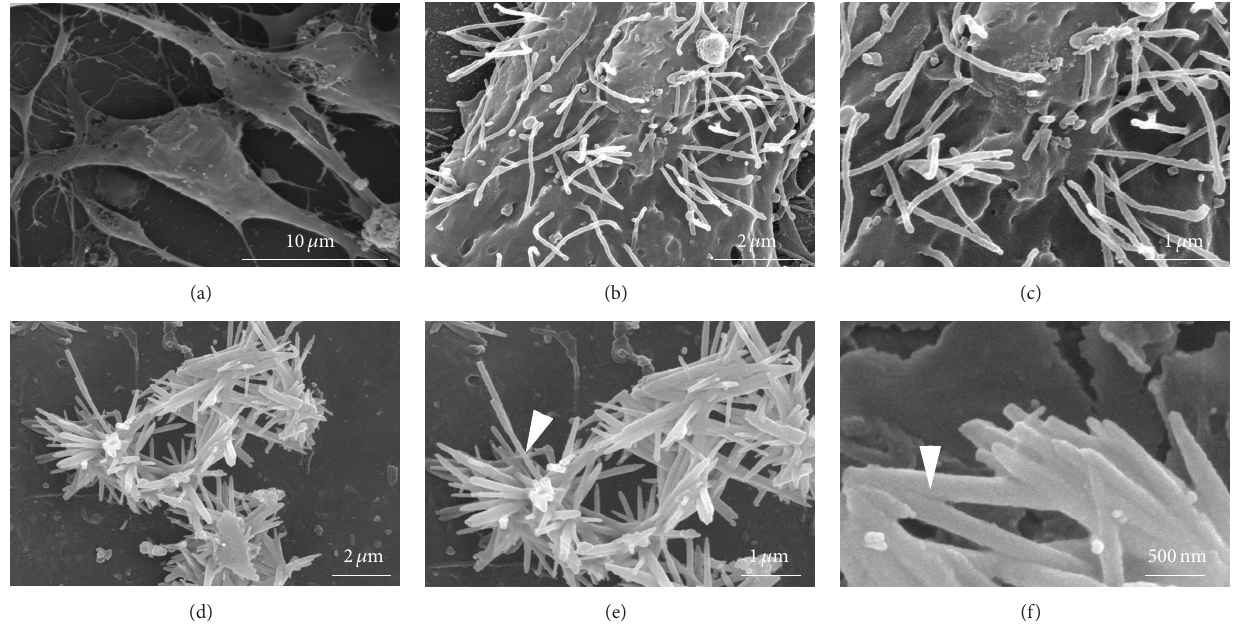
Figure 5: The surface of differentiated cells observed by scanning electron microscopy. (a) The surface of the cochlear multipotent cells had no stereocilia. ((b) and (c)) Cells differentiated on poly-L-lysine (as shown in Figure 2(a)) with some hair-cell-like cells displaying disorganized stereocilia. (d) Cells differentiated on the mitotically inactivated chicken utricle stromal cells (as shown in Figure 2(a)) showed hair bundle- like structures. (e) The stereocilia of the hair-cell-like cells were tapered at their bases (arrowhead in (e)). (f) Many interstereocilia links existed among the tips of stereocilia (arrowhead in